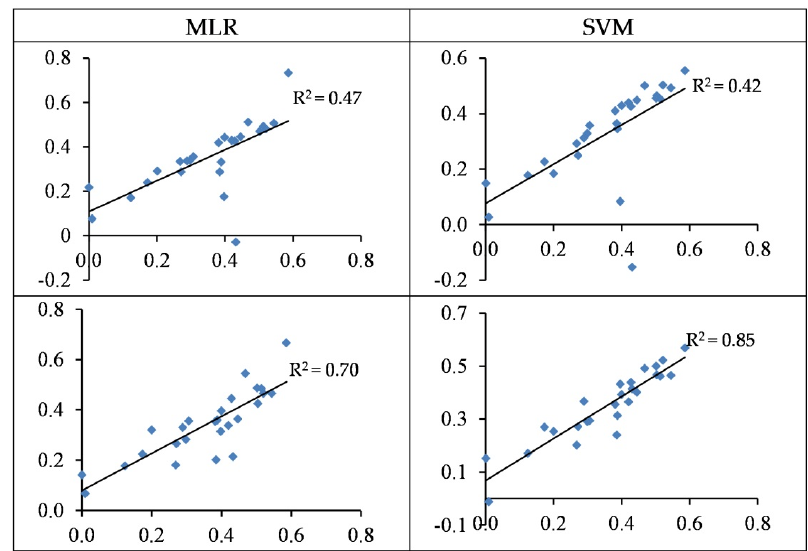
Figure 6. Standardized values (between 0 and1) of the observed (horizontal axis) and the predicted (vertical axis) concentration of Zn based on wavelengths (top) and spectral indices (bottom) in the testing sets of the SVM and MLR methods.